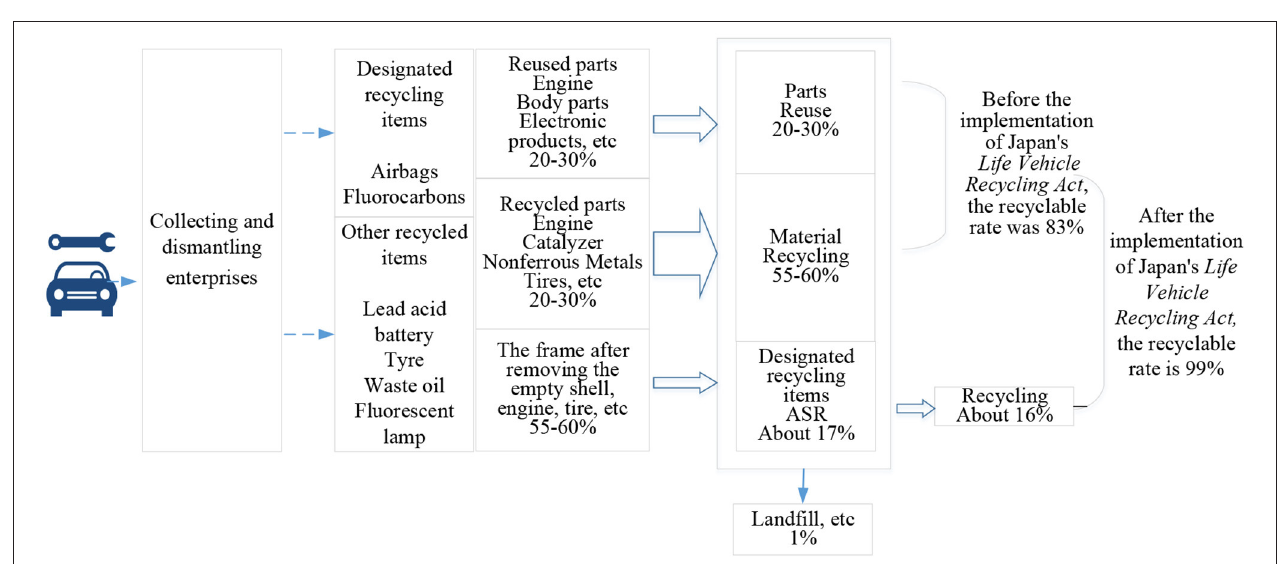
FIGURE 6 | GWP difference between new engines and remanufactured engines in different scenarios.